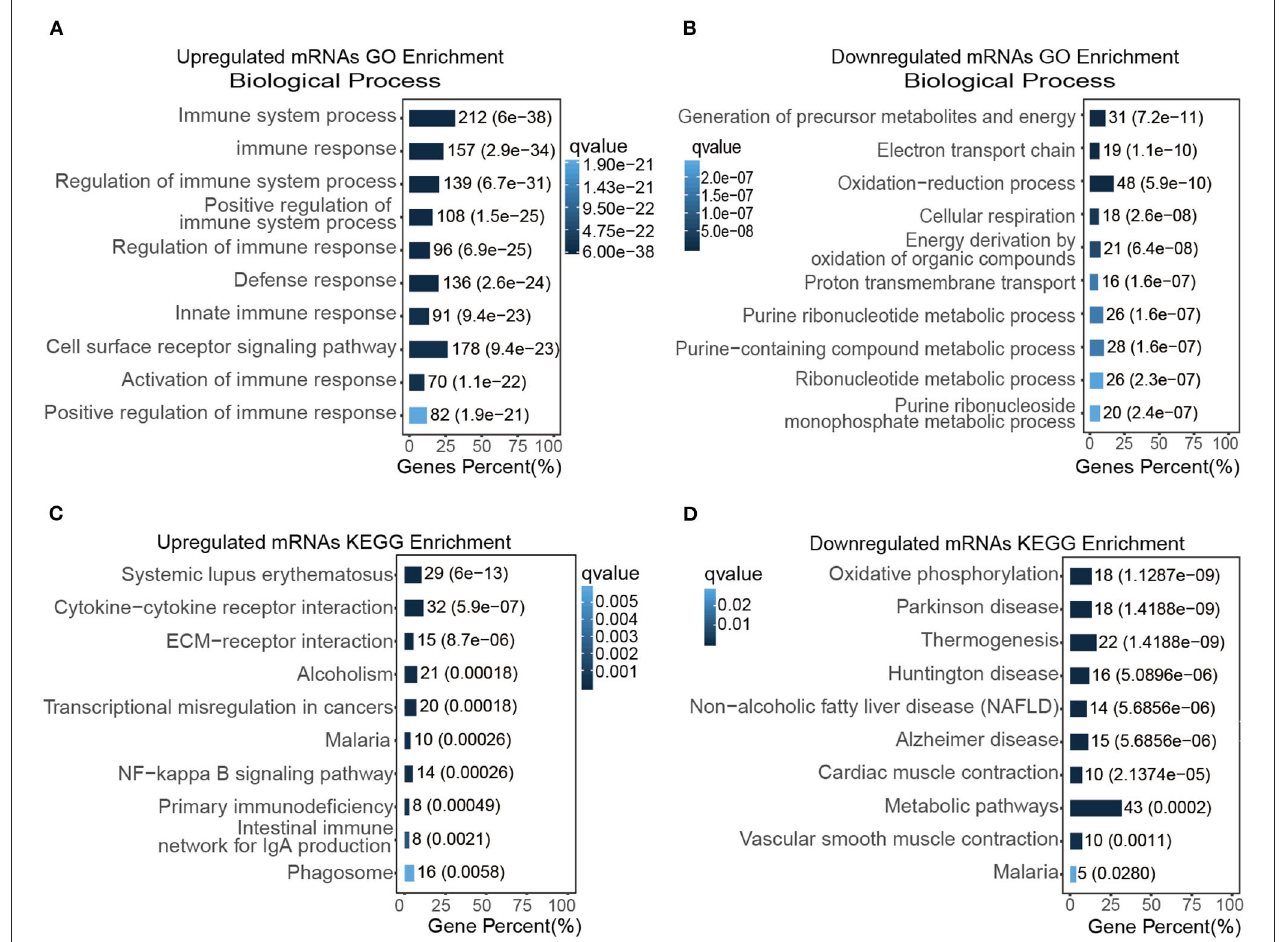
FIGURE 3 | Functional enrichment assay of transcripts in the TAC model. (A,B) The top GO enriched biological functions of up (A) and down-regulated DEGs (B) , respectively; (C,D) the top KEGG enrichment items of up (C) and down-regulated DEGs (D) ,